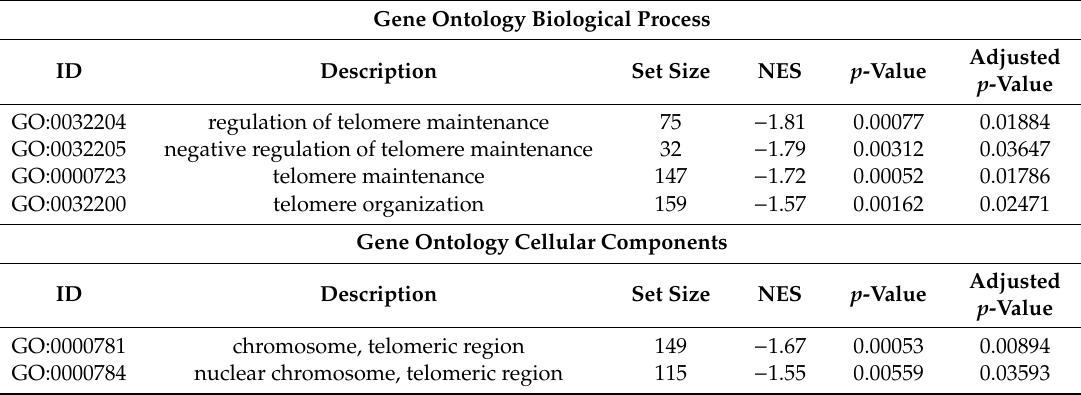
Table 6. Significantly enriched gene groups (FDR < 0.05) related to